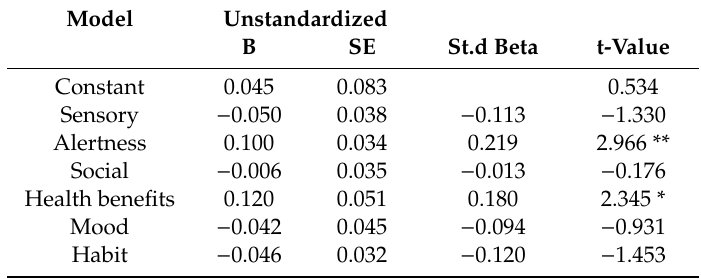
Table 8. Results of regression analysis of motivations that influence energy drink consumption.